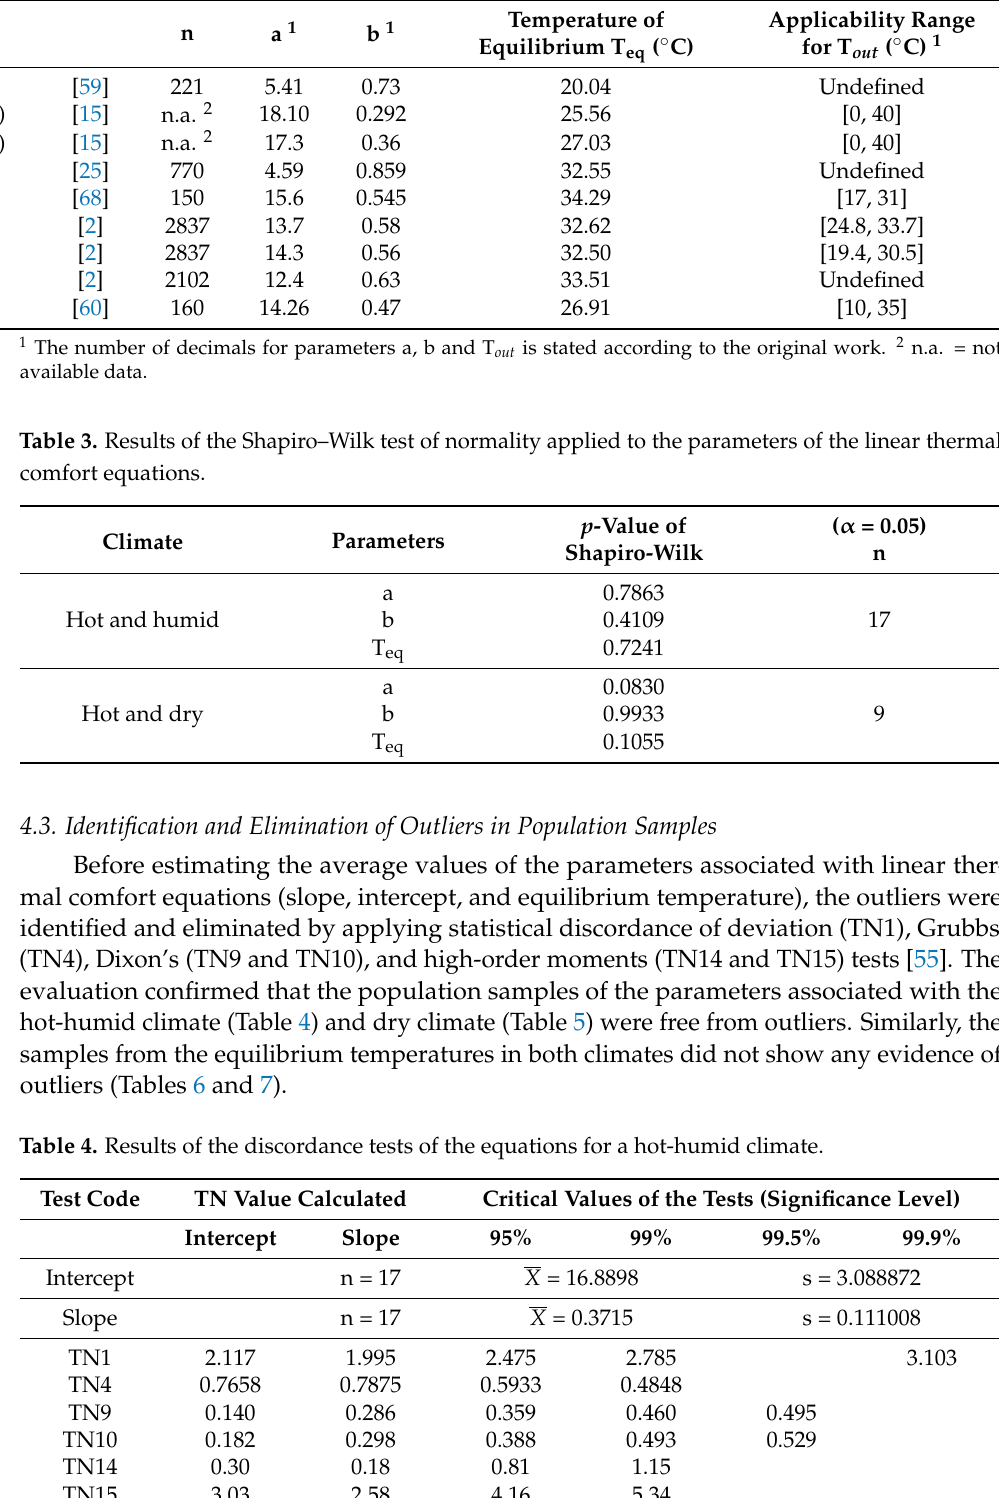
Table 2. Parameters of the equations of thermal comfort in a hot-dry climate.